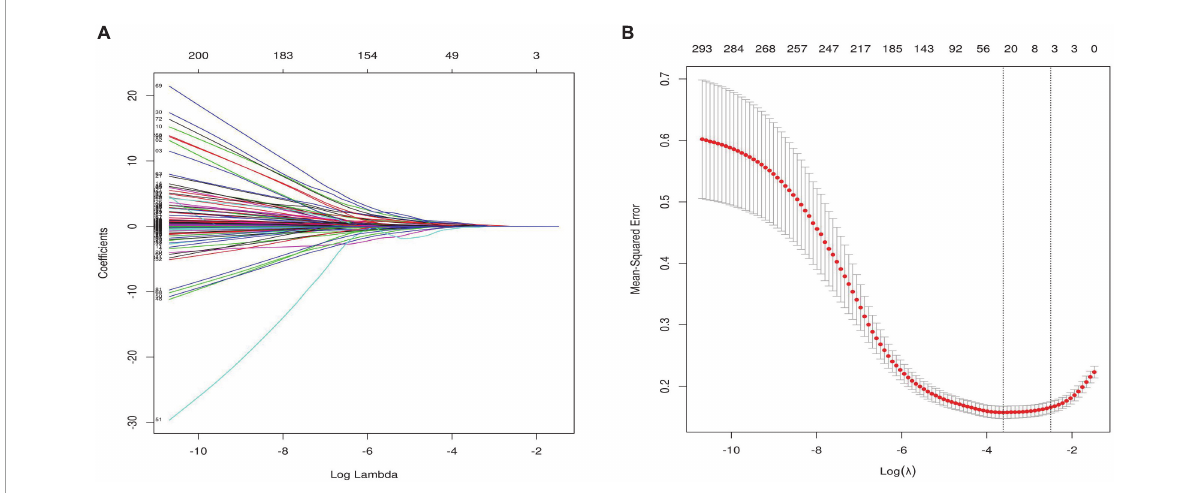
FIGURE3 Feature selection using the least absolute shrinkage and selection operator (LASSO) binary logistic regression model. (A) LASSO coefficient profiles of the 320 features. Vertical line was drawn at the value selected using 10-fold cross-validation, where optimal resulted in 26 non-zero coefficients. (B) Tuning parameter ( λ ) selection in the LASSO model used 10-fold cross-validation via minimum criteria. A coefficient profile plot was produced against the log ( λ ) sequence. The area under the receiver operating characteristic (AUC) curve was plotted versus log( λ ). This is consistent with the glmnet package recommendation for choosing λ , as either λ min (minimum mean square error) or this value plus one standard